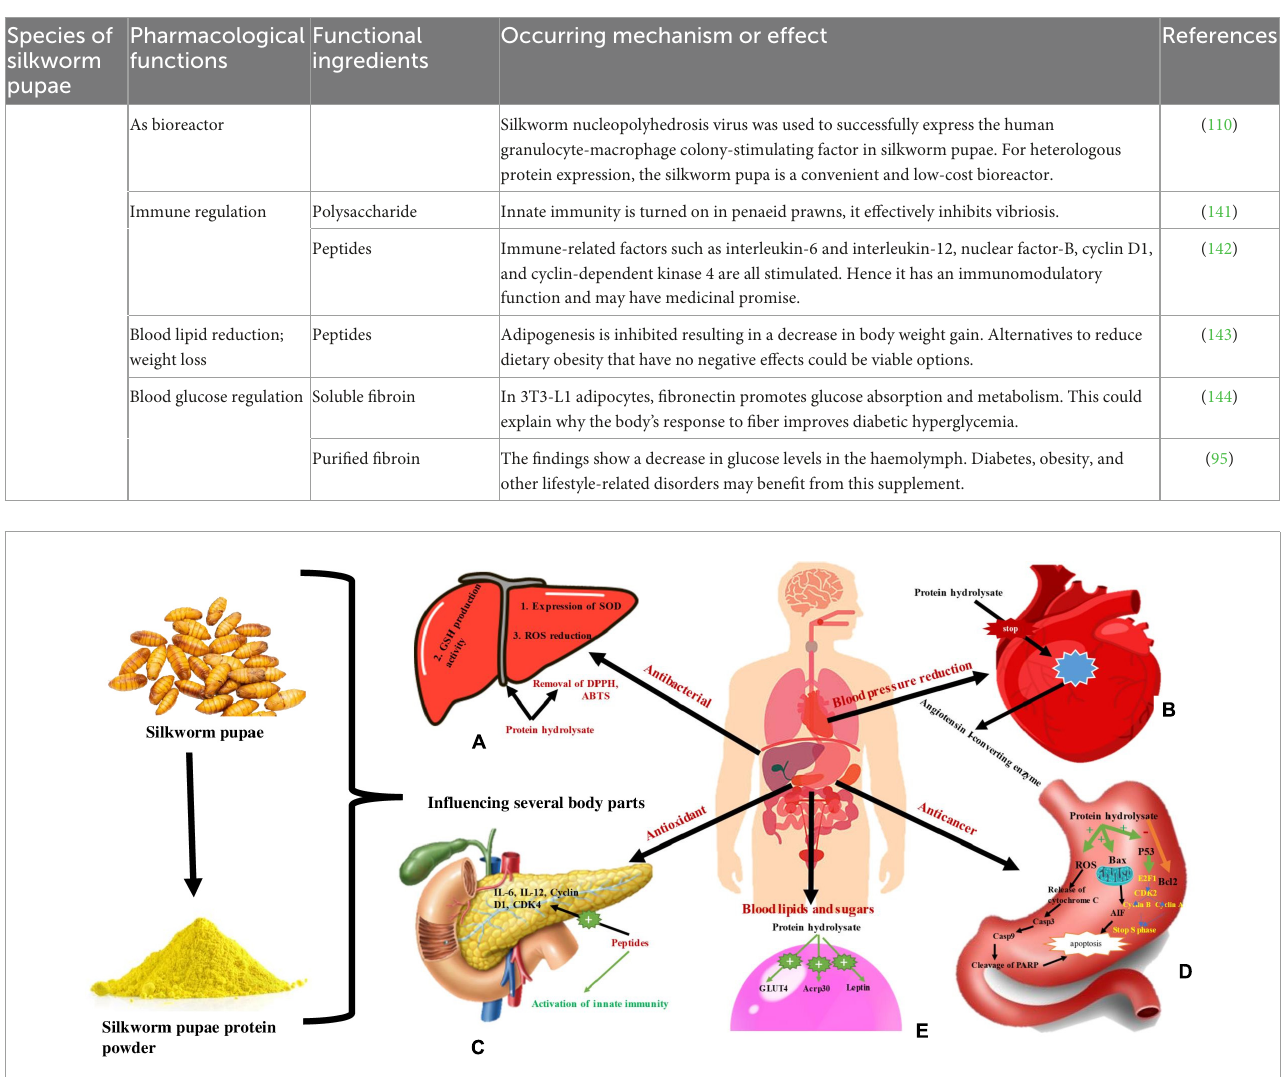
FIGURE7 Representing use of silkworm pupae proteins in different function and physiological mechanisms. (A) Consumption of pupal protein is used as antibacterial agent as protein hydrlysate regulates GSH production activity, Expression of SOD and ROS reduction. (B) Pupal protein is used for reducing blood pressure by inhibiting Angiotensin I-converting enzyme by protein hydrolysate. (C) Pupal protein is used as antioxidant as it activate innate immunity and activate IL-6, IL-12, Cyclin, D1, CDK4. (D) Pupal protein is used as anticancer agent as protein hydrolysate activates ROS, Bax, P53 which cause apoptosis and also stop S- phase of cell division. (E) Pupal protein impact on decreasing blood lipids and sugar level as protein hydrolysate activate GLUT4, Acrp30, and